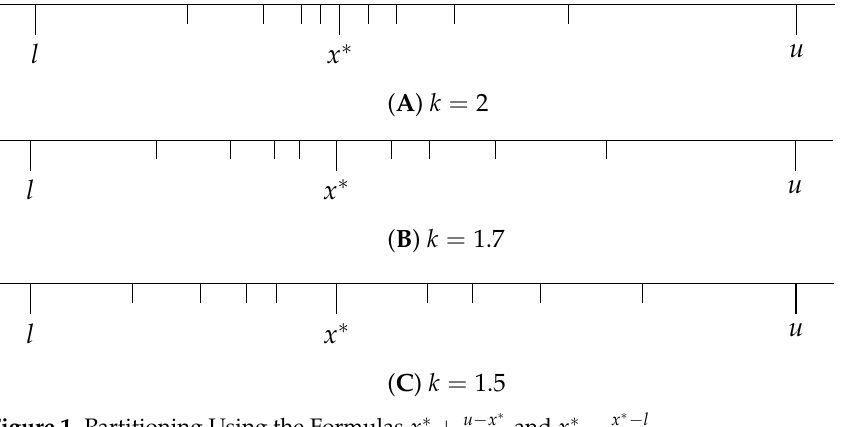
Figure 1. Partitioning Using the Formulas x ∗ + u − x ∗